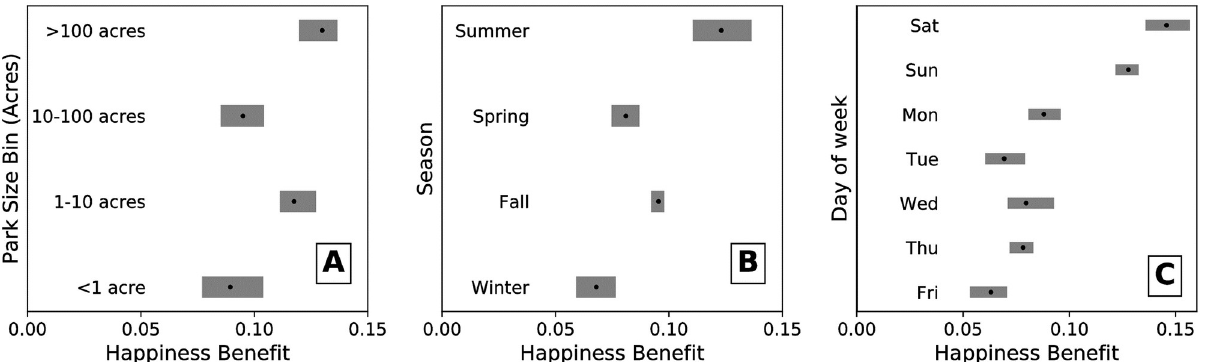
Fig 4. Temporal analysis of happiness benefit. A . Happiness benefit by park size. The largest category of parks (greater than 100 acres) had the highest happiness benefit. B . Happiness benefit by season, with summer and fall exhibiting the highest mean happiness benefit values. C . Happiness benefit by day of the week, with the weekend days higher than other days of the week. In all three panels, the range is the full range of happiness benefits from 10 runs, sampling 80% of tweets. 1,000 random in-park tweets were pooled in each group from each city. Control tweets were selected as tweets most temporally proximate to the in-park tweet from the same